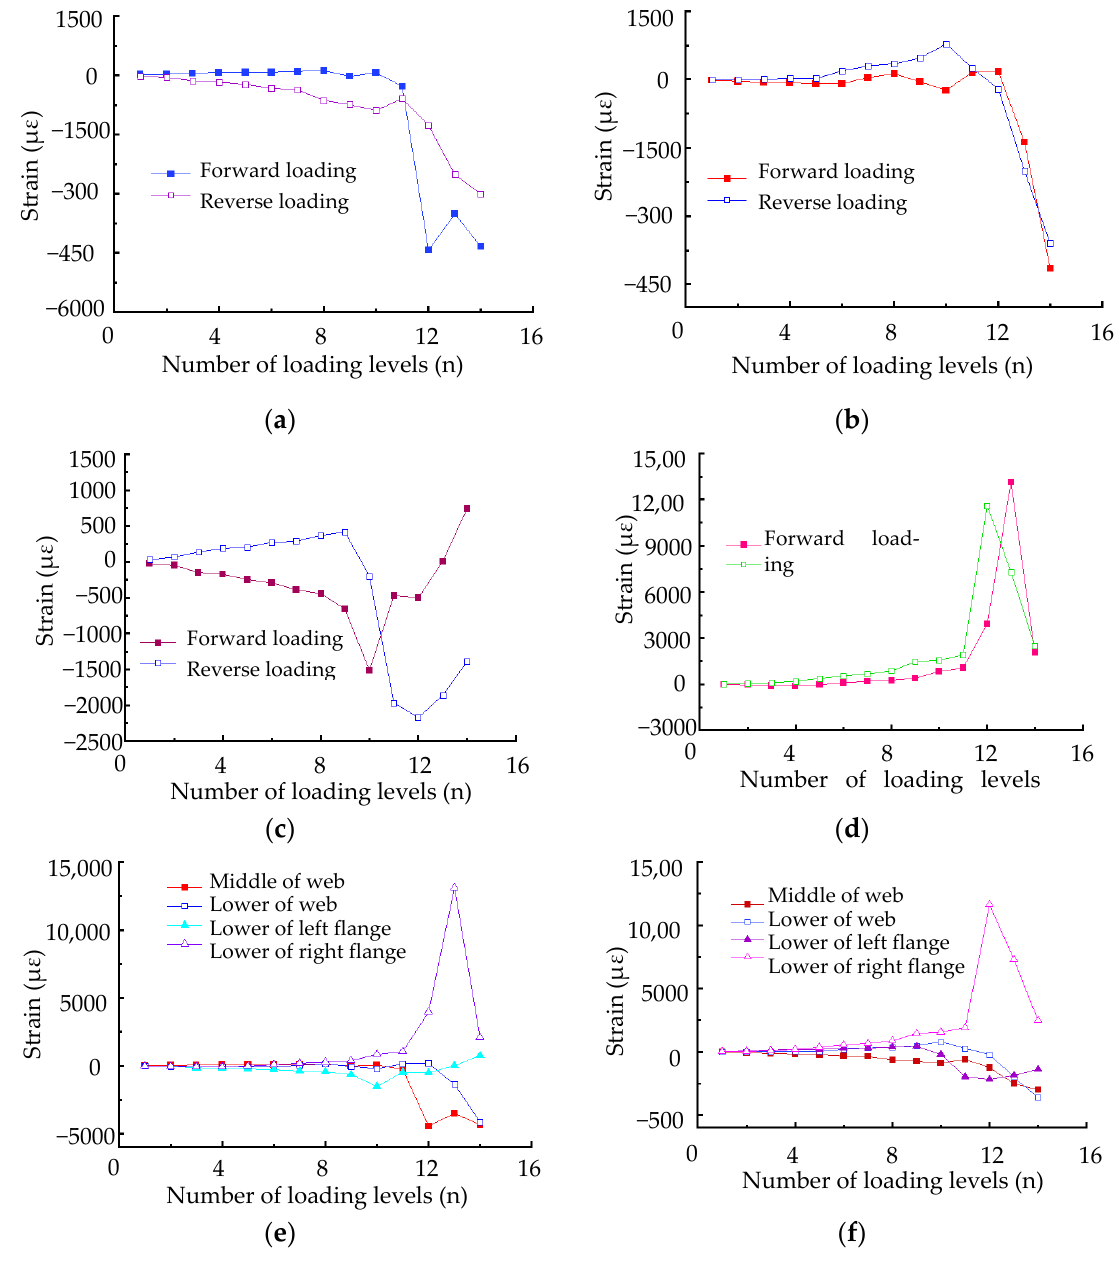
Figure 21. Variations of strains in the left column of specimen 1: ( a ) Strains at the middle of web; ( b ) Strains at the lower part of web; ( c ) Strains at the lower part of left flange; ( d ) Strains at the lower part of right flange; ( e ) Strains during forwarding loading; ( f ) Strains during reverse loading.